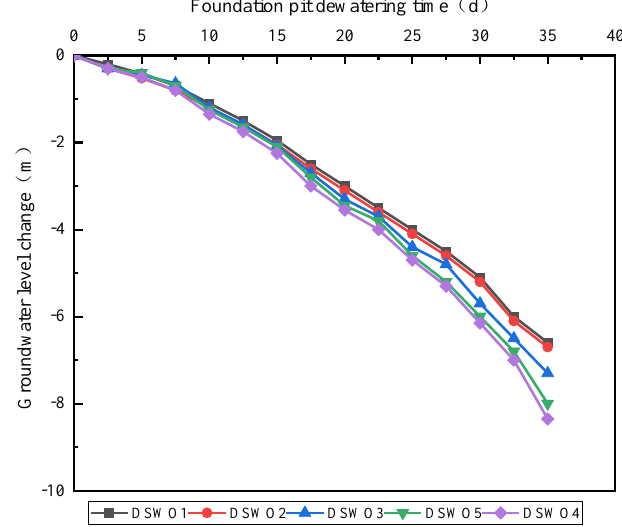
Figure 6. Amount of groundwater level change at monitoring sites.